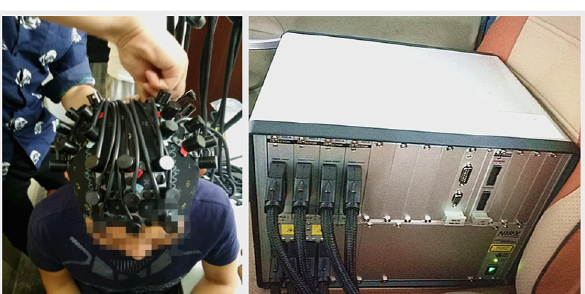
Figure 3 The NIRx device used in this study